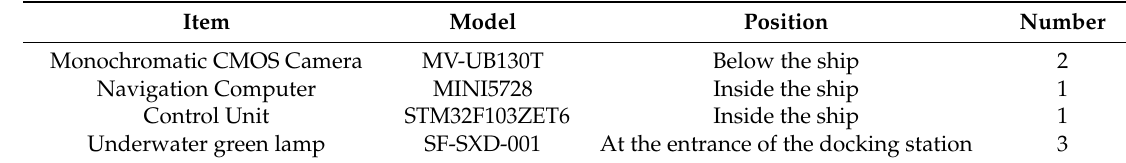
Figure 1. Main components of the test-bed platform. Table 1. Specifications of the main